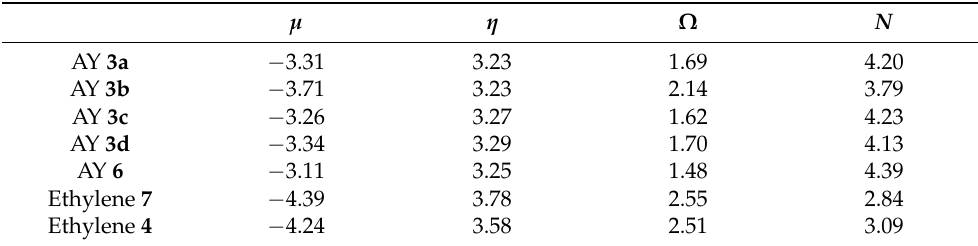
Table 7. B3LYP/6-31G(d) electronic chemical potential µ , chemical hardness η , electrophilicity ω and nucleophilicity N , in eV, of AYs 3a – d and 6 and ethylene derivatives 4 and 7